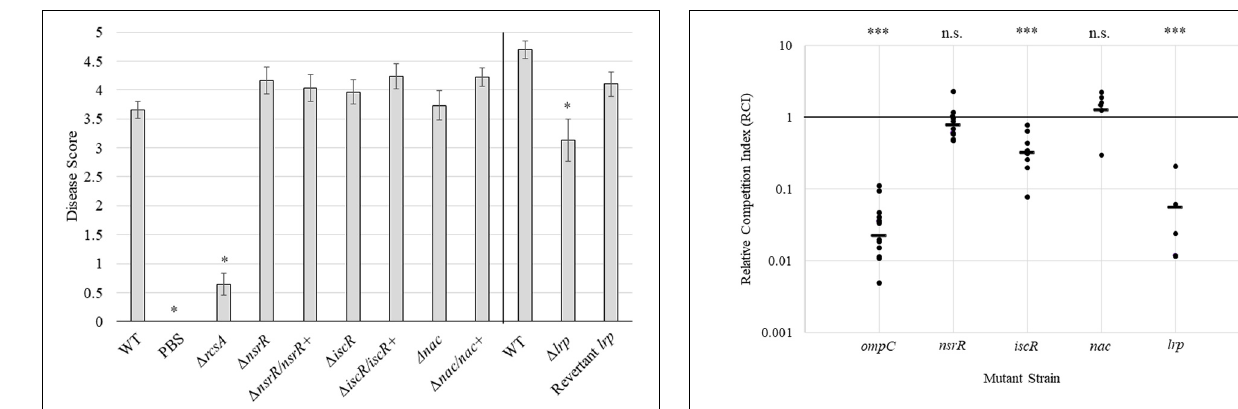
FIGURE 3 | Virulence of P. stewartii nsrR , iscR , lrp , and nac mutant and complementation or revertant strains. Average disease score for the indicated P. stewartii strains with WT, (cid:49) rcsA , and PBS controls. Scores were collected 10 days postinoculation from a minimum of 15 plants (“Jubilee” or “B73” seeds were used for the data shown on left or right side of the vertical bar, respectively). An asterisk ( ∗ ) represents a significant difference from the appropriate WT strain ( p ≤ 0.01) using Student’s t -test. Error bars were calculated using the standard error for each set.